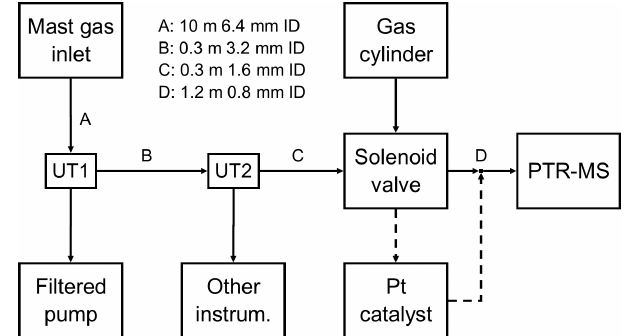
Figure 1. Schematic of the tubing set-up used to draw atmospheric sample to the gas instrument (PTR-MS). Dashed lines represent the set-up of the platinum catalyst before the synthetic gas blank was added. UT represents union tee, a three-way static